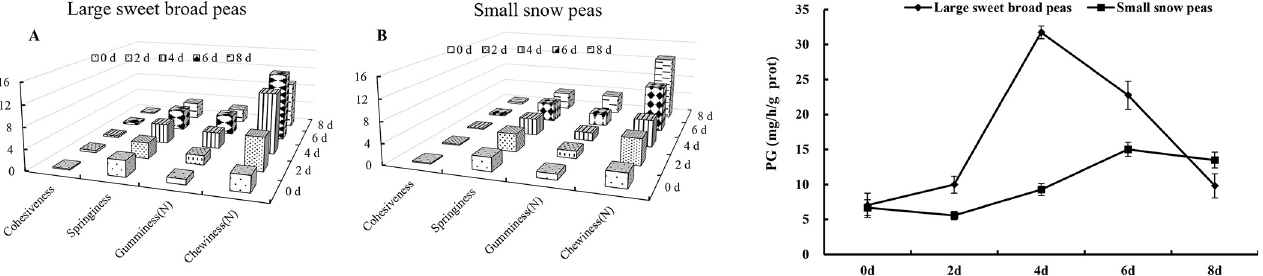
Fig 5. Changes in texture characteristics AB) and PG enzyme activity (C) of legume vegetables during storage.